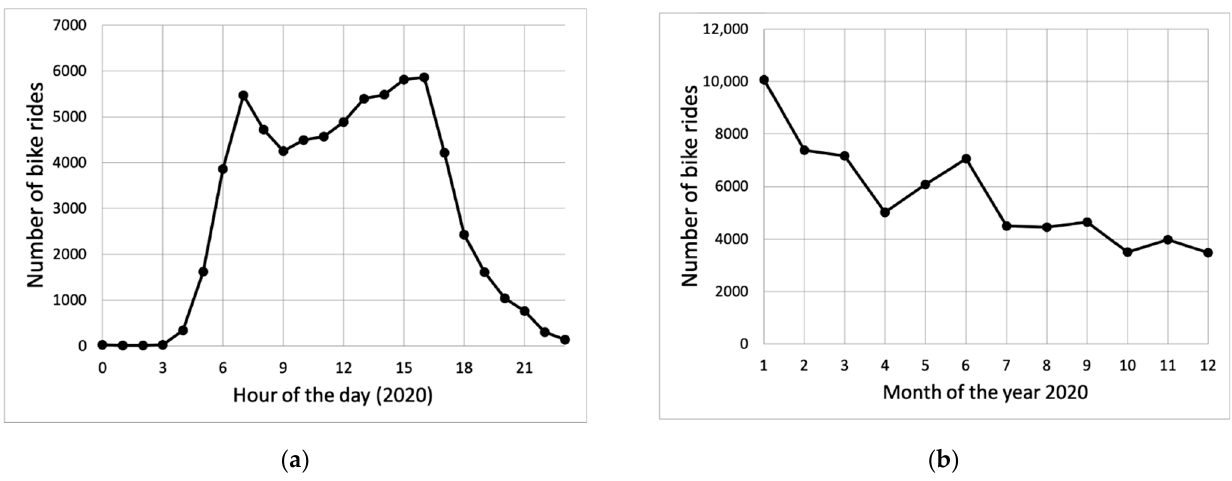
Figure 8. ( a ) The number of bicycle trips with valid data for the present analysis in 2020 as a function of the hour of the day and ( b ) the number of bicycle trips with valid data as a function of the month of 2020.